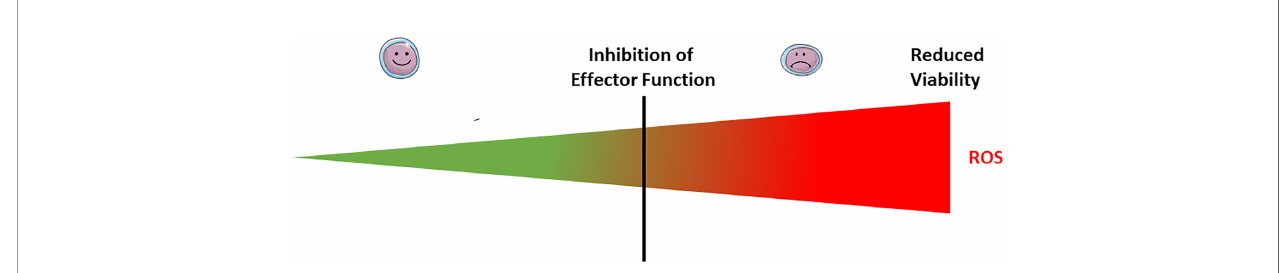
FIGURE 2 | Exogenous ROS modulate lymphocyte effector functions and viability. At low doses of microenvironmental ROS, both B and T lymphocytes have normal effector function (smiley face lymphocytes). Exposure to mild doses of exogenous ROS affects the lymphocyte effector functions (weary face lymphocytes), while acute exposure to high doses affects their viability. The threshold between mild and acute exposure strongly depends upon the lymphocyte subset and